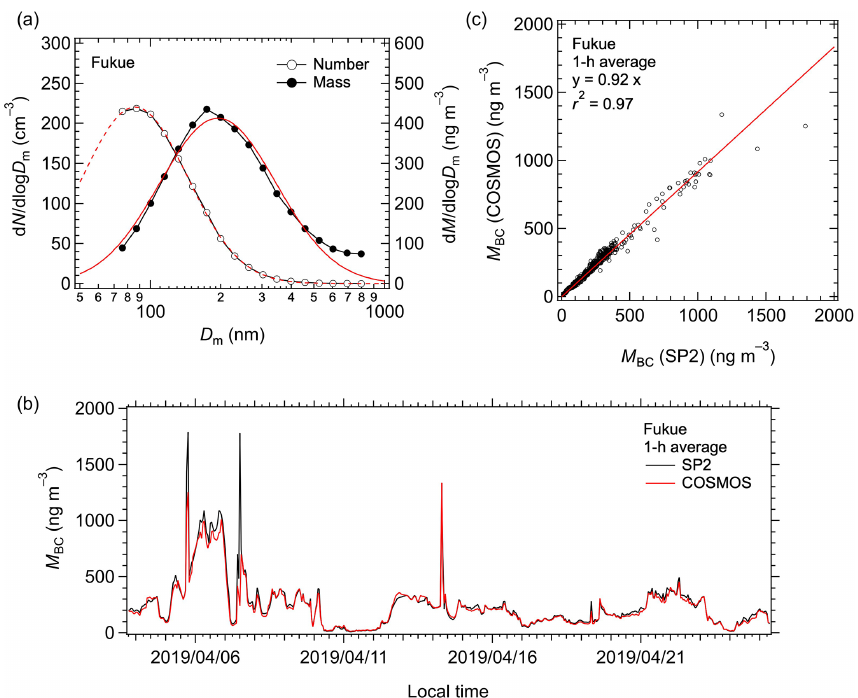
Figure 12. (a) Number and mass size distributions of BC averaged over the observation period at Fukue in April 2019. The dashed (solid) red line is the lognormal fit to the number (mass) size distribution. (b) Time series (1h data) and (c) correlation of M BC measured by COSMOS and SP2. The solid red line in the correlation plot is the least-squares regression forced through the origin. Table 11. MAC cor and r 2 for MAAP, PSAP–CLAP, and Aethalometer at λ = 550nm at observation sites in this